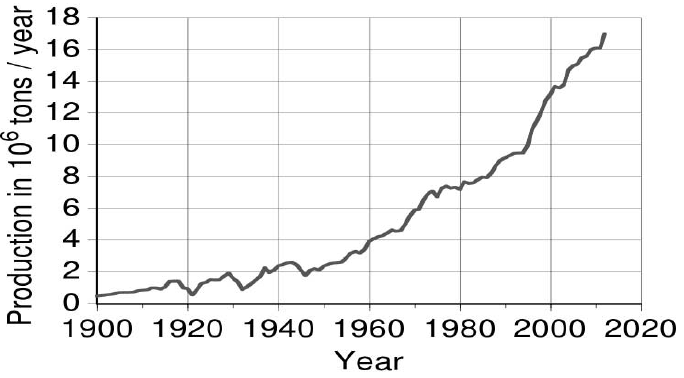
Figure 1. Global production of copper [15].